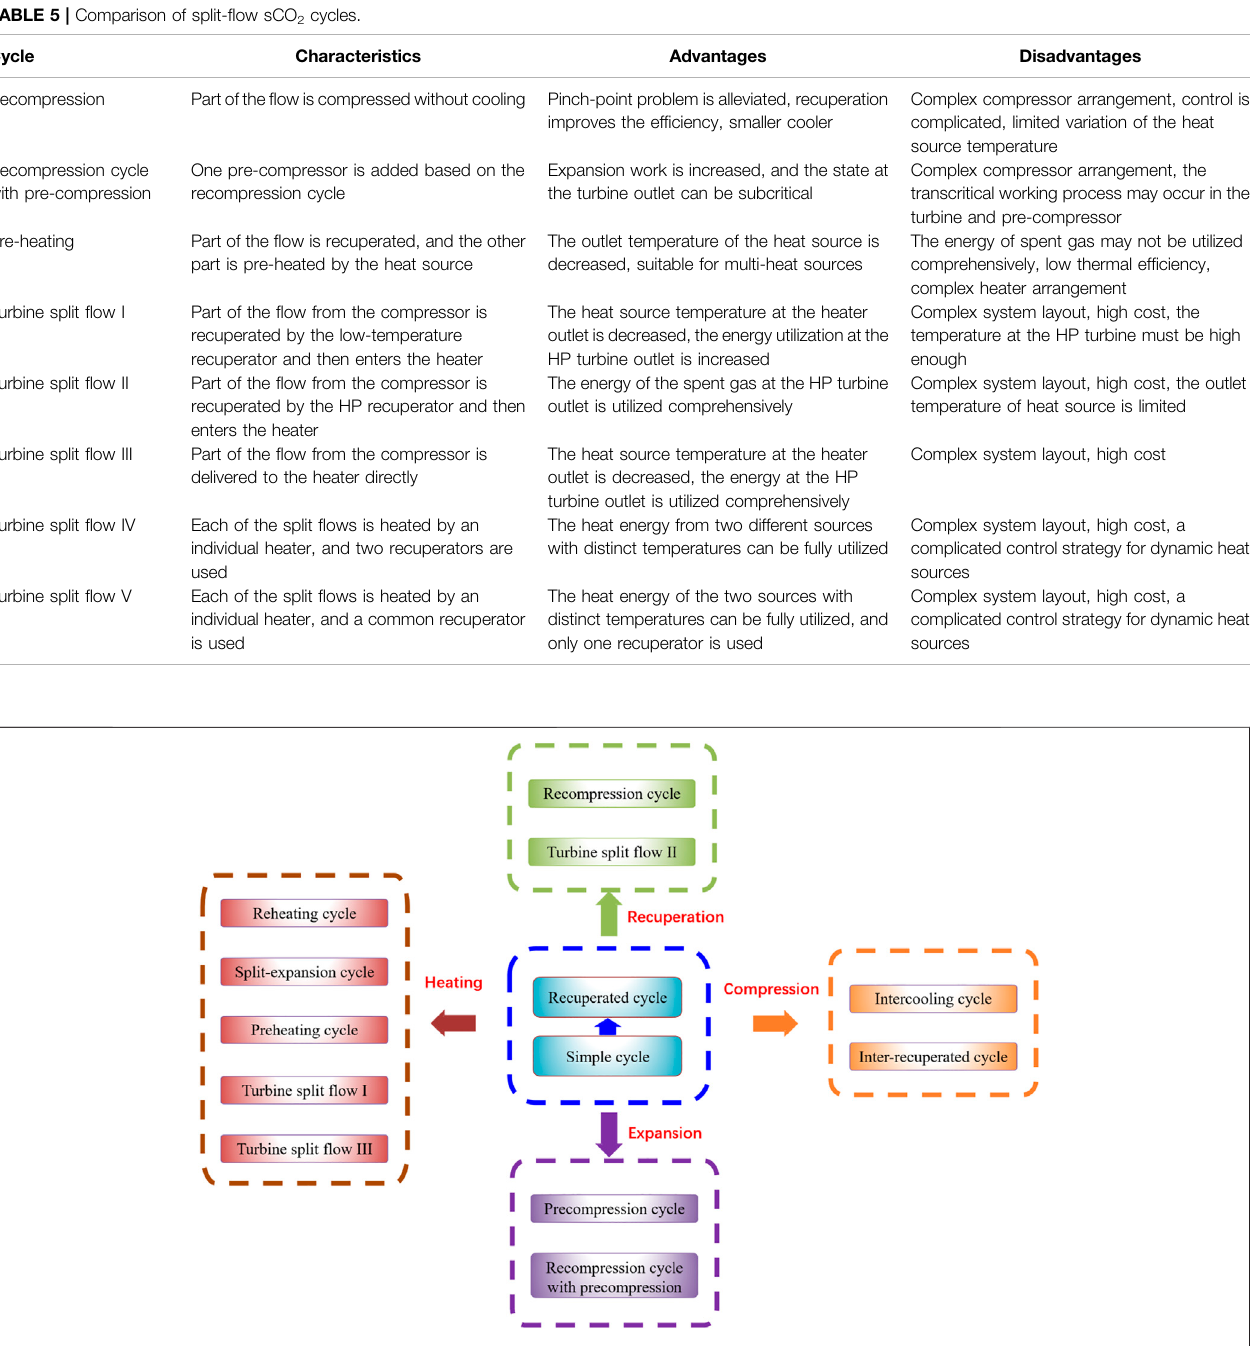
FIGURE 6 | Improvement paths for sCO 2 Brayton